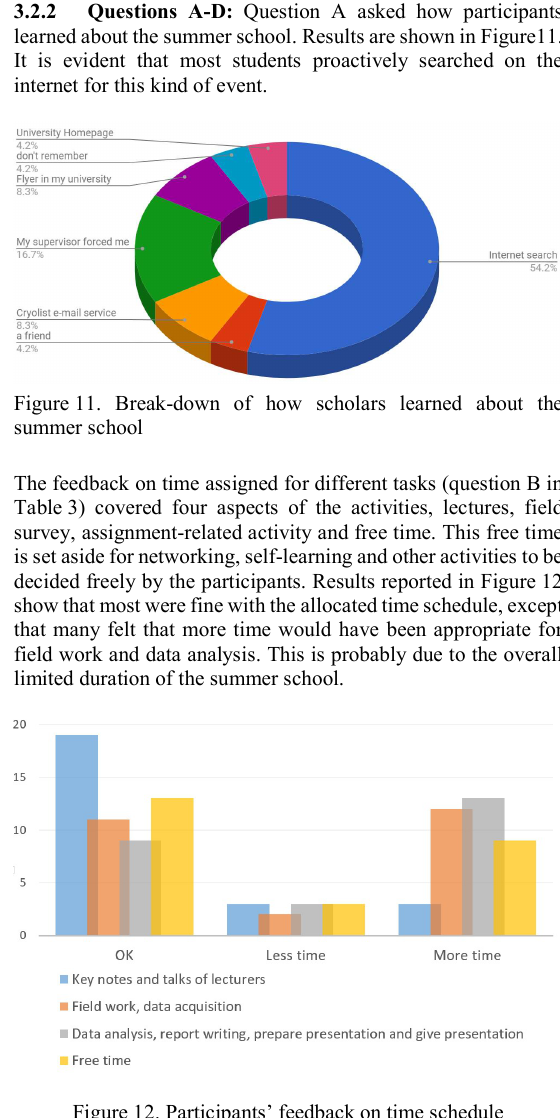
Figure 12. Participants’ feedback on time